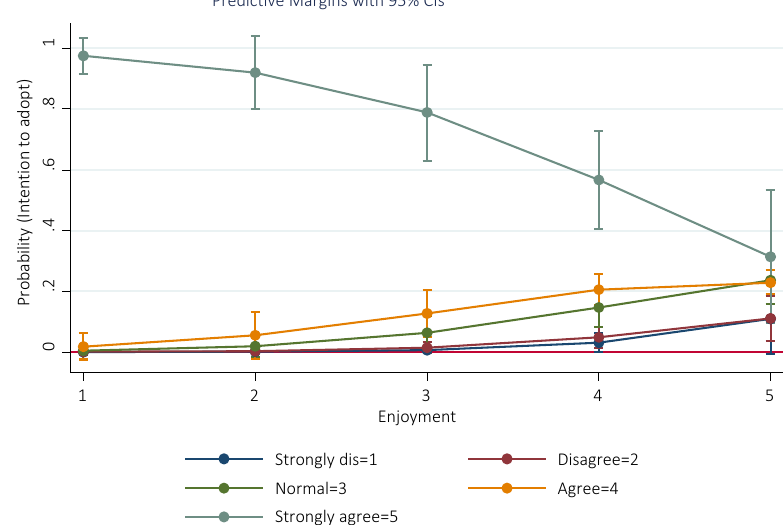
Figure 1. Marginal effects of interaction between economic benefit and enjoyment on the probability of intention to join the gig economy (all three regions)